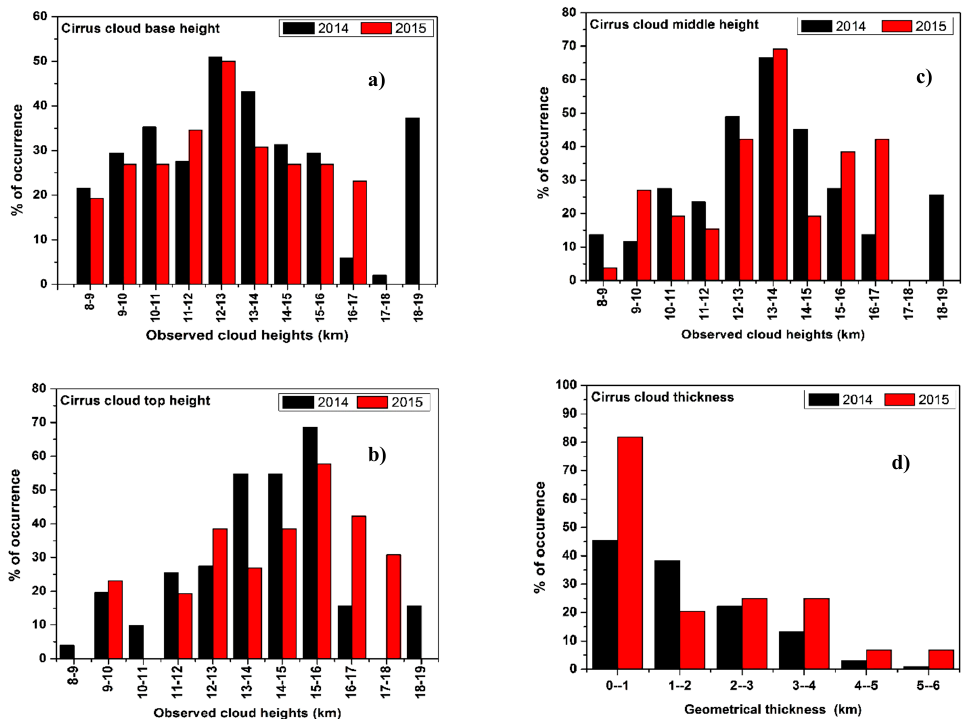
( c ) cirrus cloud middle height; and ( d ) cirrus cloud geometrical thickness. Table 2. Mean, standard deviation, and median (parentheses) of geometrical properties of cirrus clouds observed over Gadanki, India (13.5°North; 79.2°North).